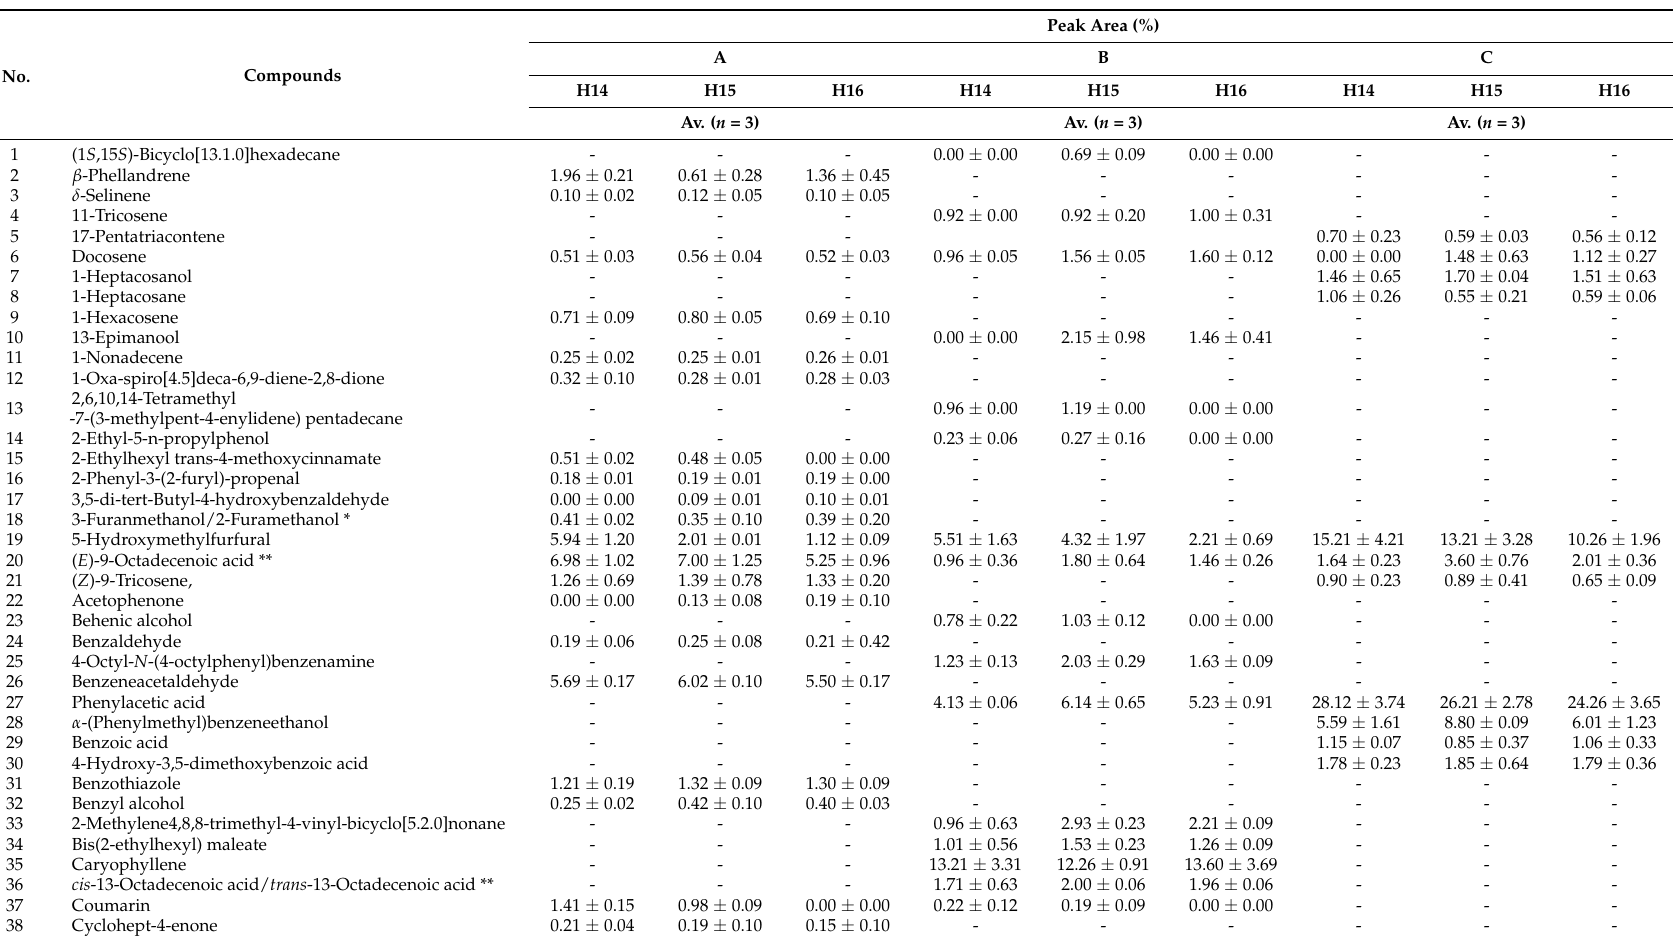
Table 1. Volatile compounds of Polish sweet yellow clover honey characterized by gas chromatography–mass spectrometry (GC-MS) in extracts obtained with different